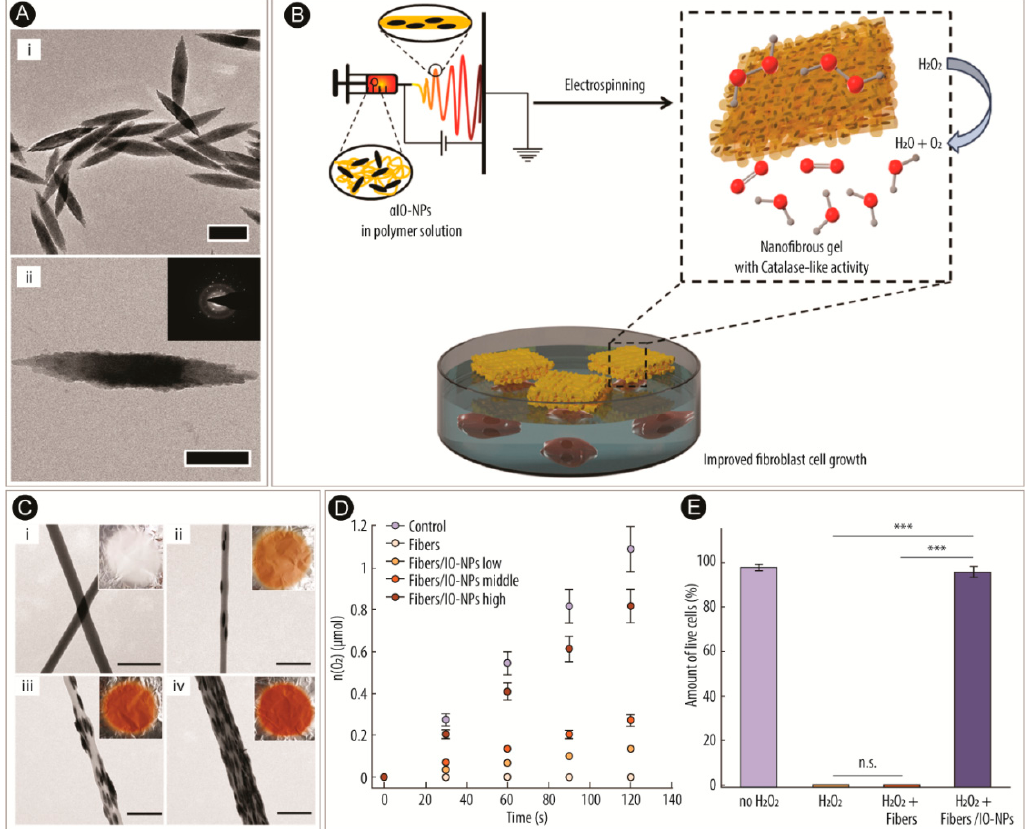
Figure 8. Fibrous dressing containing hematite nanoparticles ( α IO-NPs) with catalase-like activity to promote wound healing. TEM images of spindle-shaped α IO-NPs ( A ). Scale bar for (i): 200 nm, for (ii): 100 nm. Schematic illustration of the fabrication process of α IO-NPs containing nanofibrous dressings ( B ). Together with poly(vinyl alcohol) (PVA), the α IO-NPs are electrospun to obtain the dressing, which, due to its catalase-like activity, improves fibroblast cell growth. TEM imaging of electrospun PVA mats containing 0% (i), 19% (ii), 58% (iii), or 71% (iv) α IO-NPs ( C ). Scale bar: 1 µm.